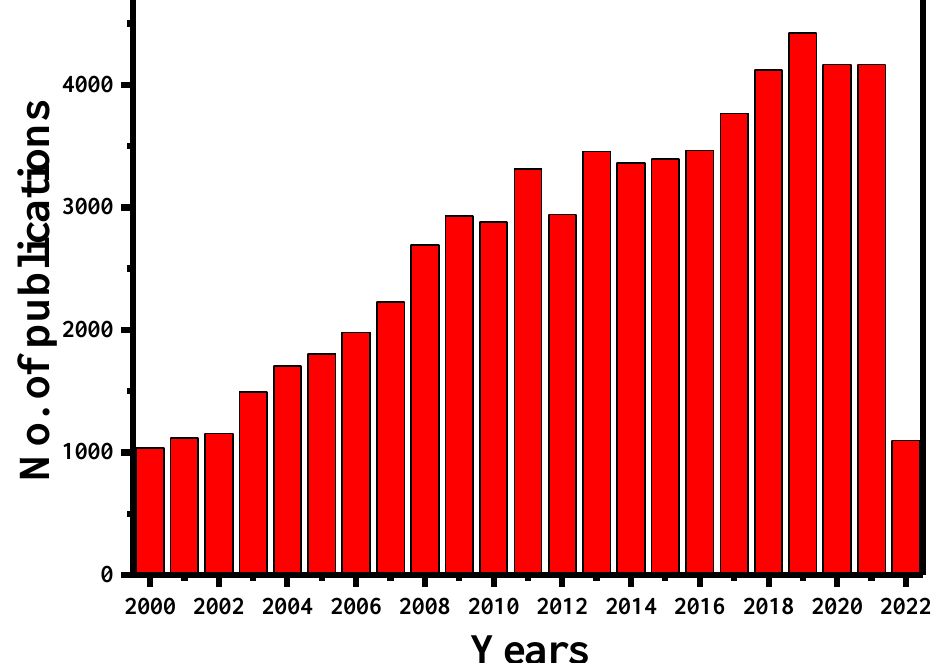
Figure 1. The number of publications on “silicon photonics sensors” over the years 2000–2022 are indexed in the Scopus database. Data were acquired on 4 April 2022.